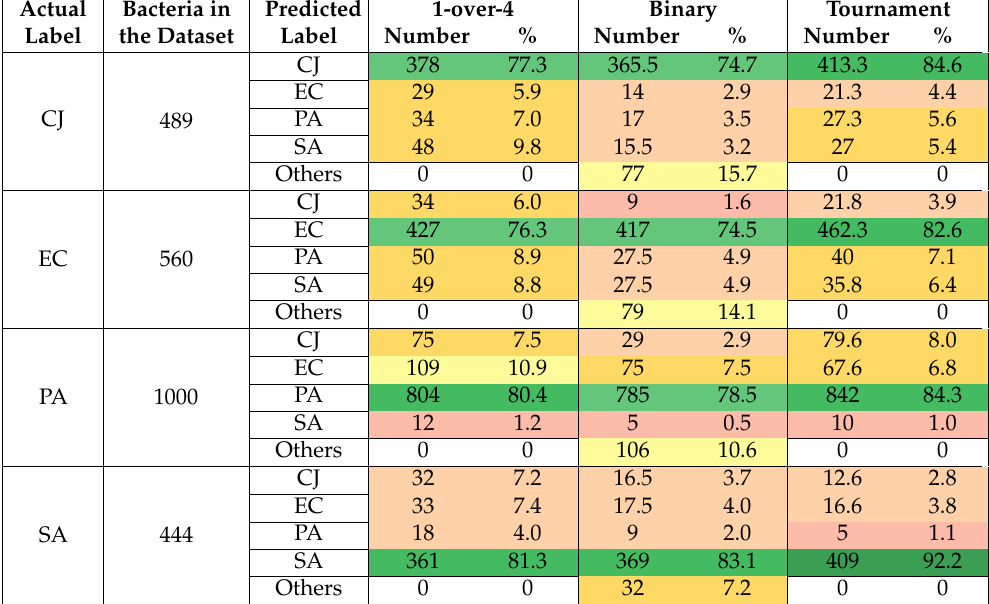
Table 2. Comparison of the individual score of each type of bacterium for images acquired in PBS for the three classification strategies: 1-over-4, binary, tournament. The cell background colour varies from red to green through orange and yellow depending on the percentage of bacteria correctly identified. The colourbar is not linear. Red corresponds to percentages below 5%, orange around 10%, yellow around 20% and green above 30%. Actual Bacteria in Predicted 1-over-4 Binary Tournament Label the Dataset